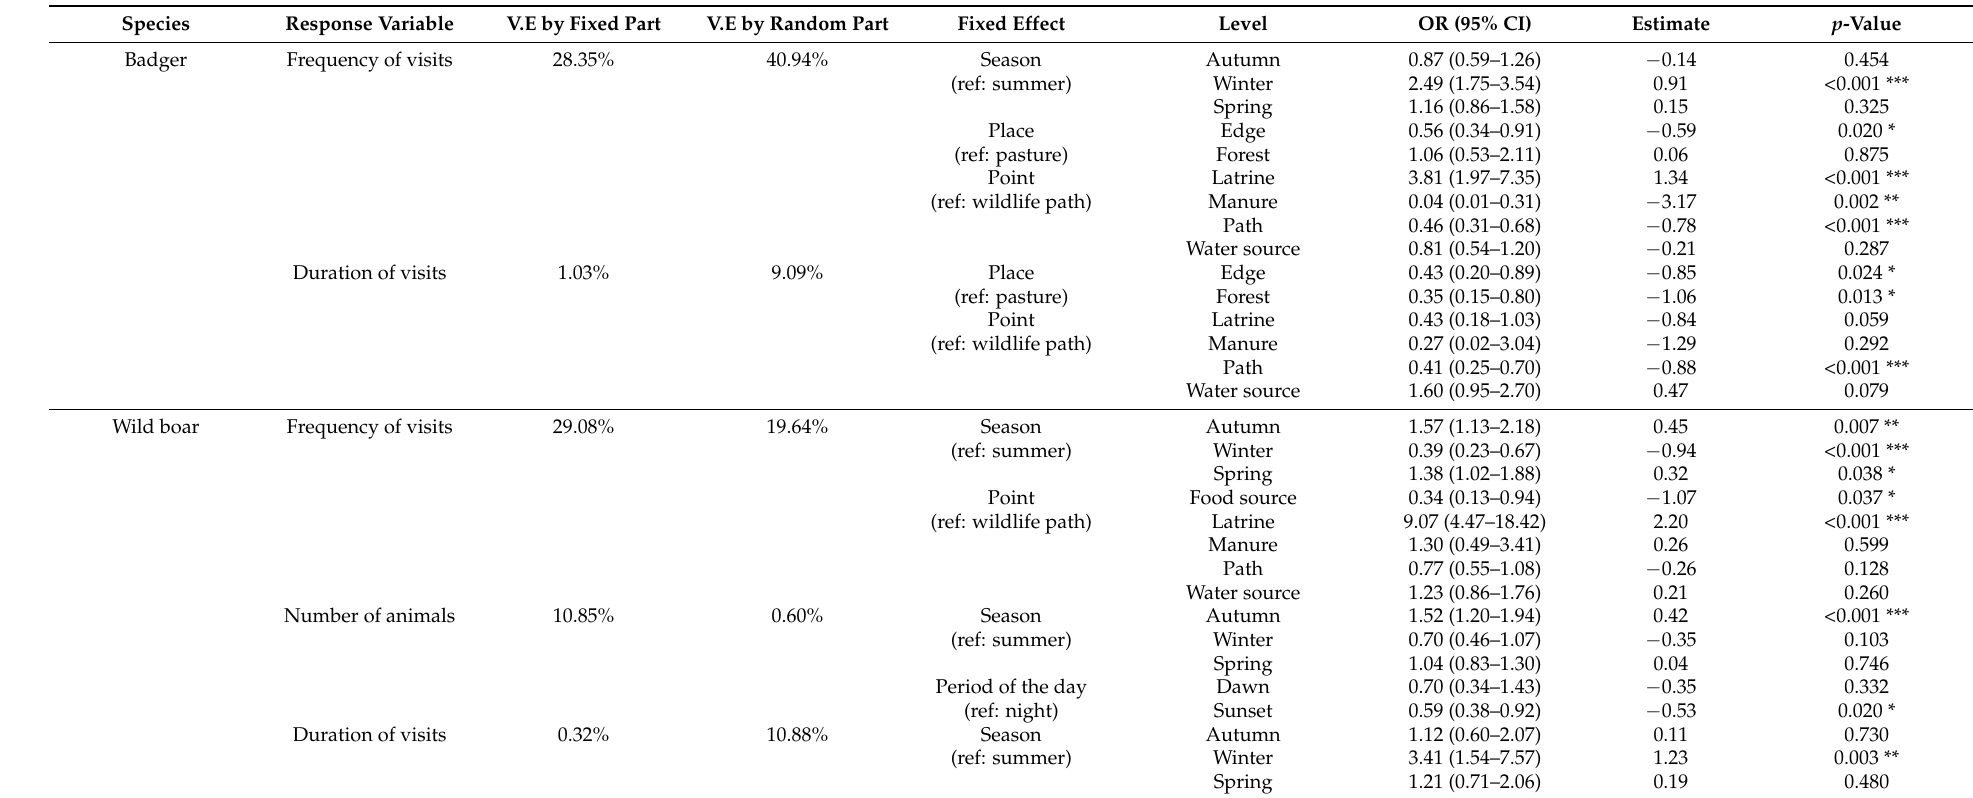
Table 5. Models selected per wild species and response variable. For each model, the table gives the percentage of variation explained by fixed and random parts of the model, and the OR, estimate and p -value of Wald test for each contrast between the reference level and the given level. The number of individuals was analyzed for wild boar only due to the quasi-absence of variability for other